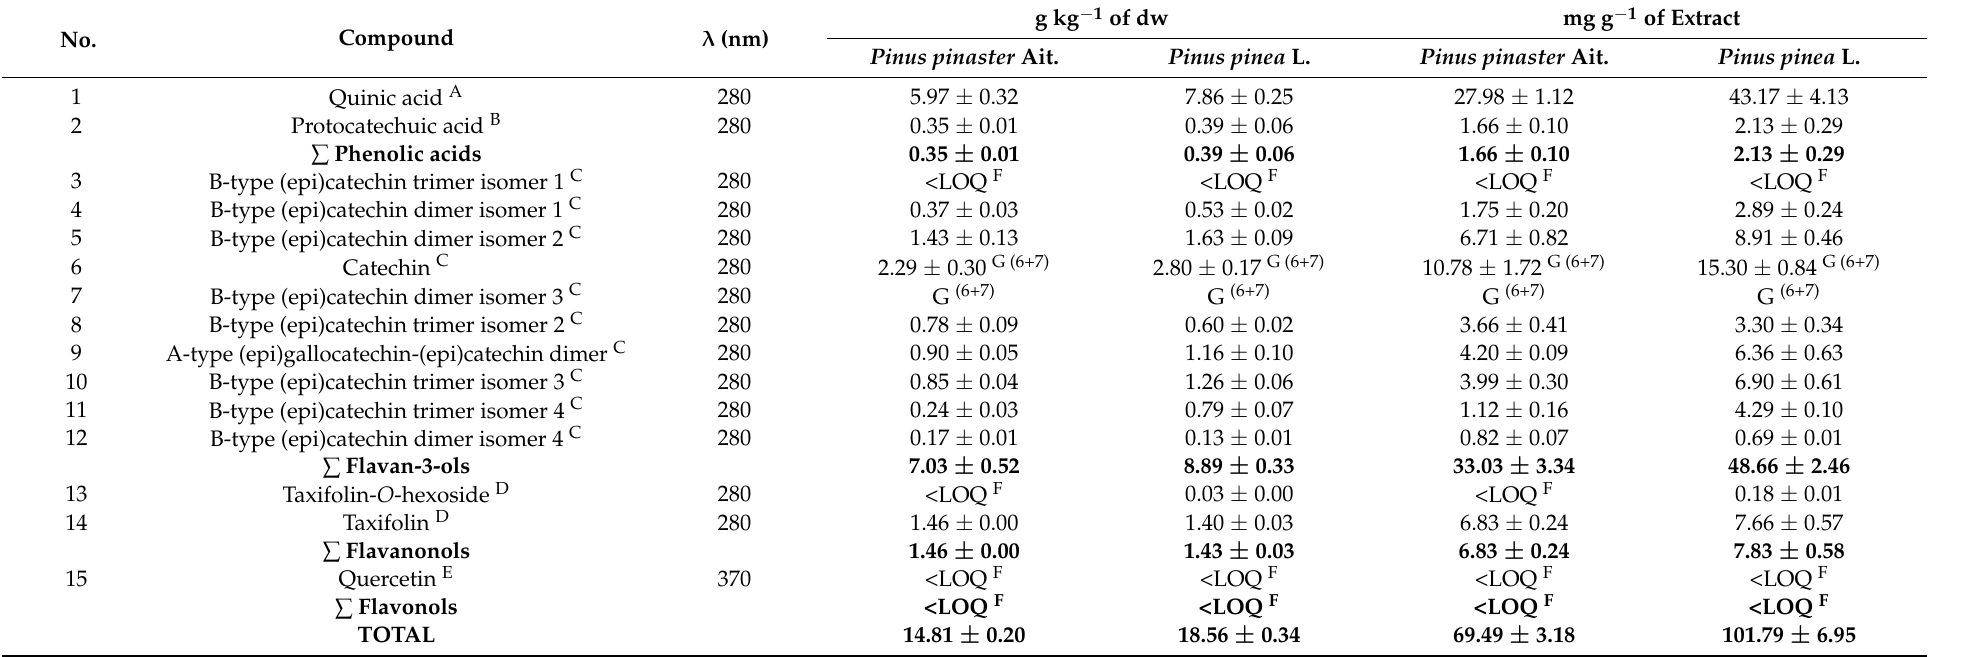
Table 4. Abundance of compounds identified in the Pinus pinaster Ait. and Pinus pinea L. bark polar